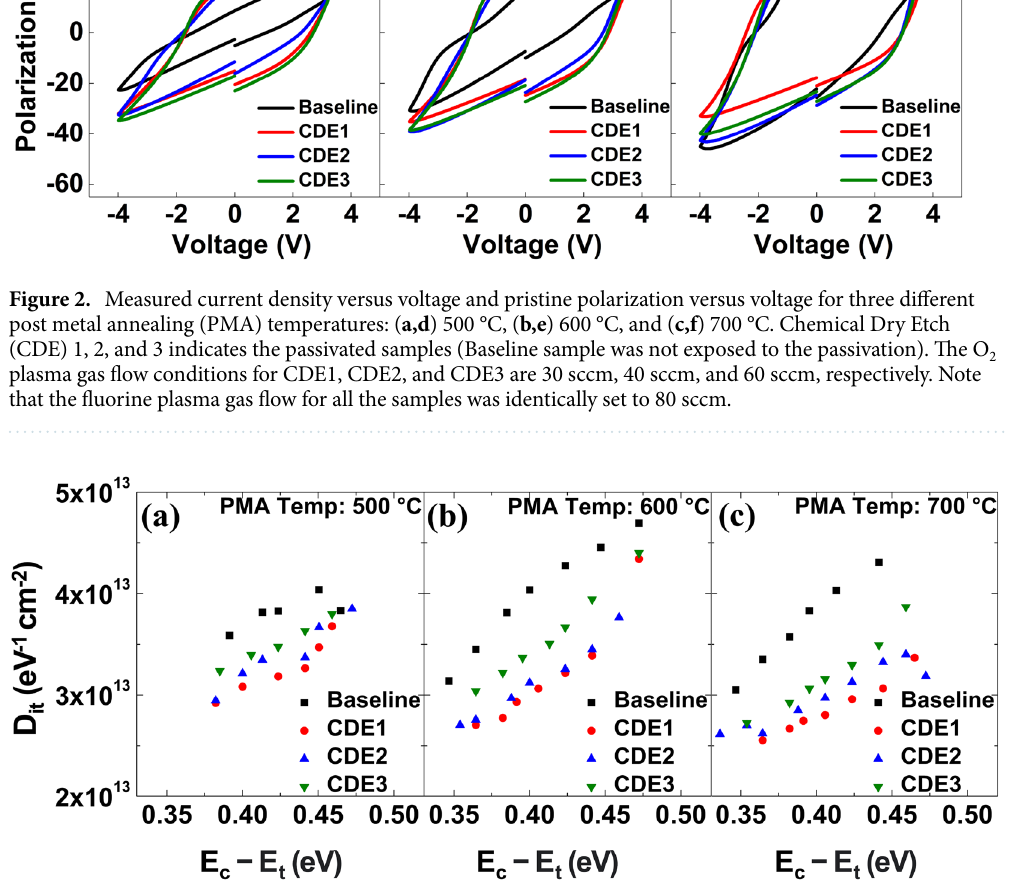
Figure 3. Trap density at the interface of SiO 2 /Si in MFIS capacitor for three different PMA temperatures: ( a ) 500 °C, ( b ) 600 °C, and ( c ) 700 °C. Note that the trap density was measured using the conductance